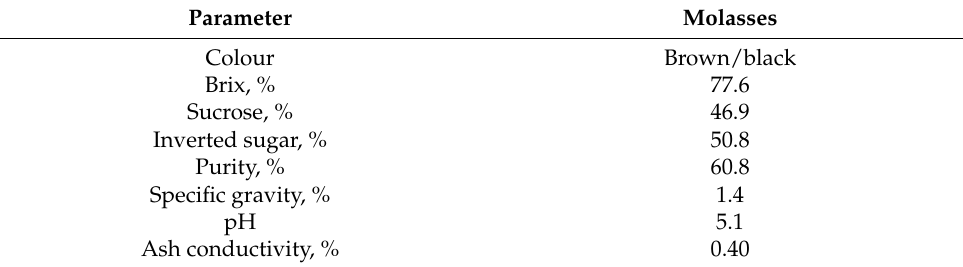
Table 1. Physicochemical characteristics of molasses